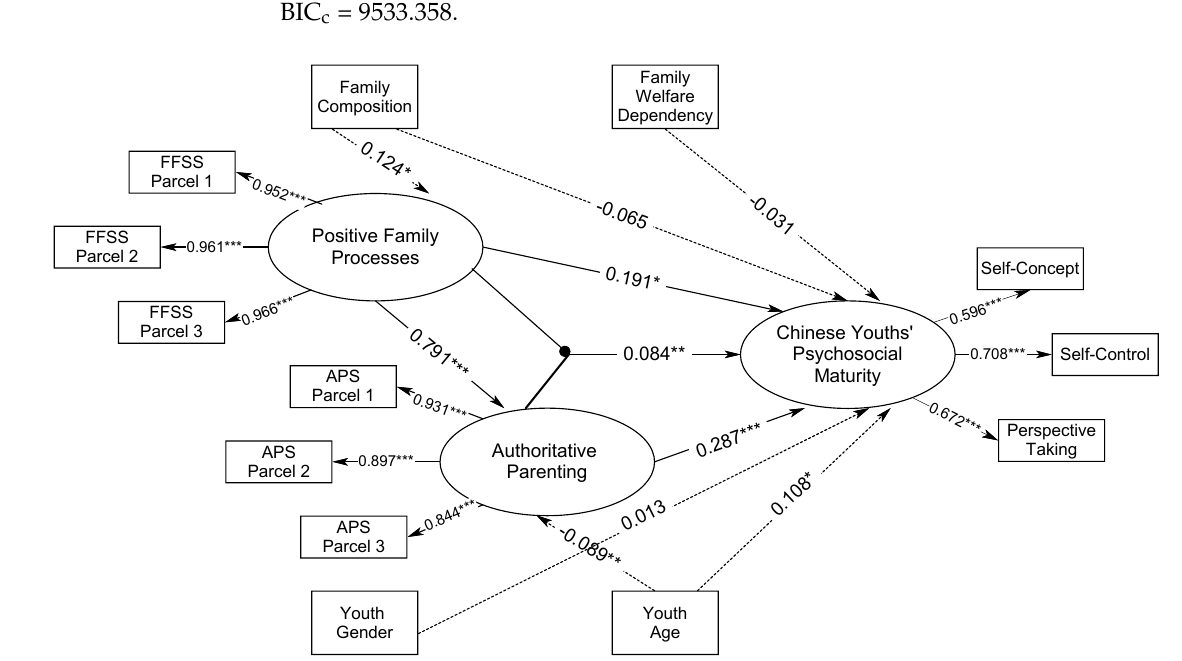
Figure 2. Structural Relationships of Positive Family Processes and Authoritative Parenting and Their Latent Interaction in Prediction of Psychosocial Maturity of Chinese Youths (Model 2). Note. AIC = 9490.267, and BIC c = 9531.053. * p < 0.05; ** p < 0.01; *** p < 0.001.